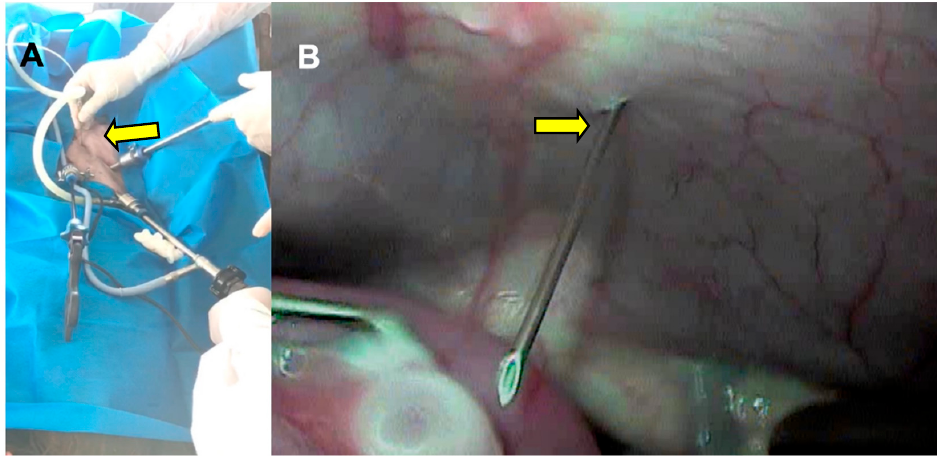
Figure 7. ( A ) Transabdominal use of the aspiration needle (arrow), caudal to the transverse plane formed by the right and left ports. ( B ) Video ‐ assisted entry of the aspiration needle (arrow) into the abdominal cavity.